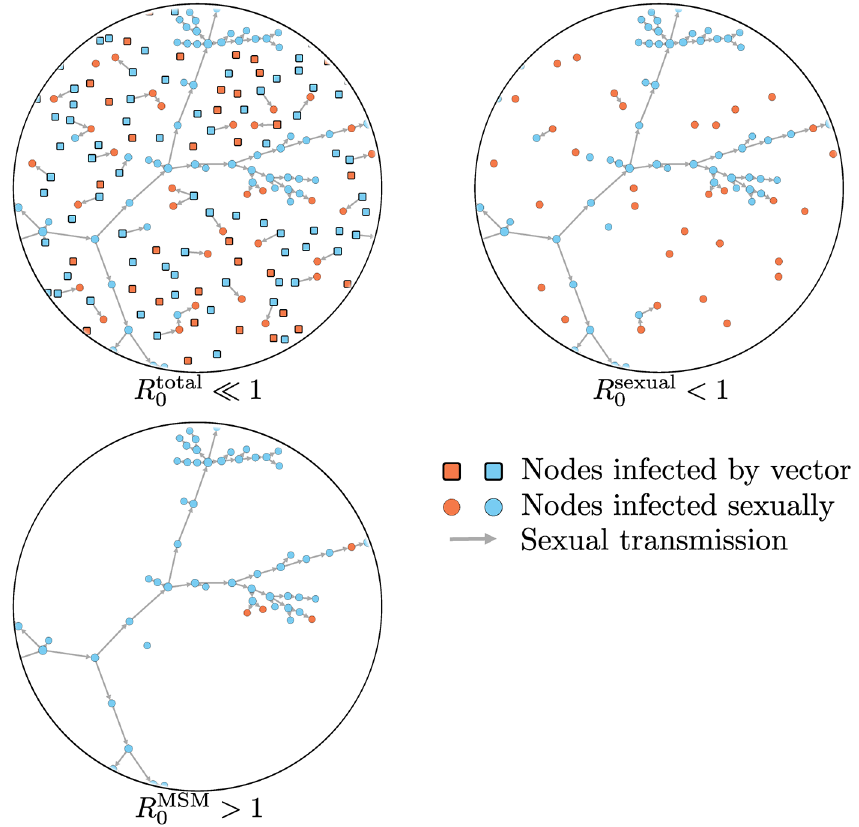
Fig 1. Women and men are shown in orange and blue, respectively, with squares indicating vector- infected individuals and circles corresponding to infections acquired sexually. Since most vector- infected individualstypically transmit ZIKV to 0 or 1 sexual partners, a biasedestimate of the relevant reproductive number for sexual transmission risk ( R total ), will be obtainedwhen consideringall infections, thus 0 inaccurately suggestingthat ZIKV cannot be a self-sustaining STI (one wouldcorrectly determinethat R total ⪡ 1 ; however,this quantity underestimates the risk of sexual transmission). Considering only 0 transmissions caused by sexually-infected individualscorrects for the bias, but still may not provide a < 1 ). In fact, becauseof the highly completeassessment of the threat posedby ZIKV as an STI ( R sexual 0 asymmetric sex-dependent probabilityof transmissionof ZIKV, an epidemicis likely to occur in the men-who- have-sex-with-men (MSM) community with some spillovertransmissionto the populationnot active in the MSM community, a situationthat can only be modeledthrough a well-suitedcommunity-specific reproductive > 1 number(e.g., R MSM 0